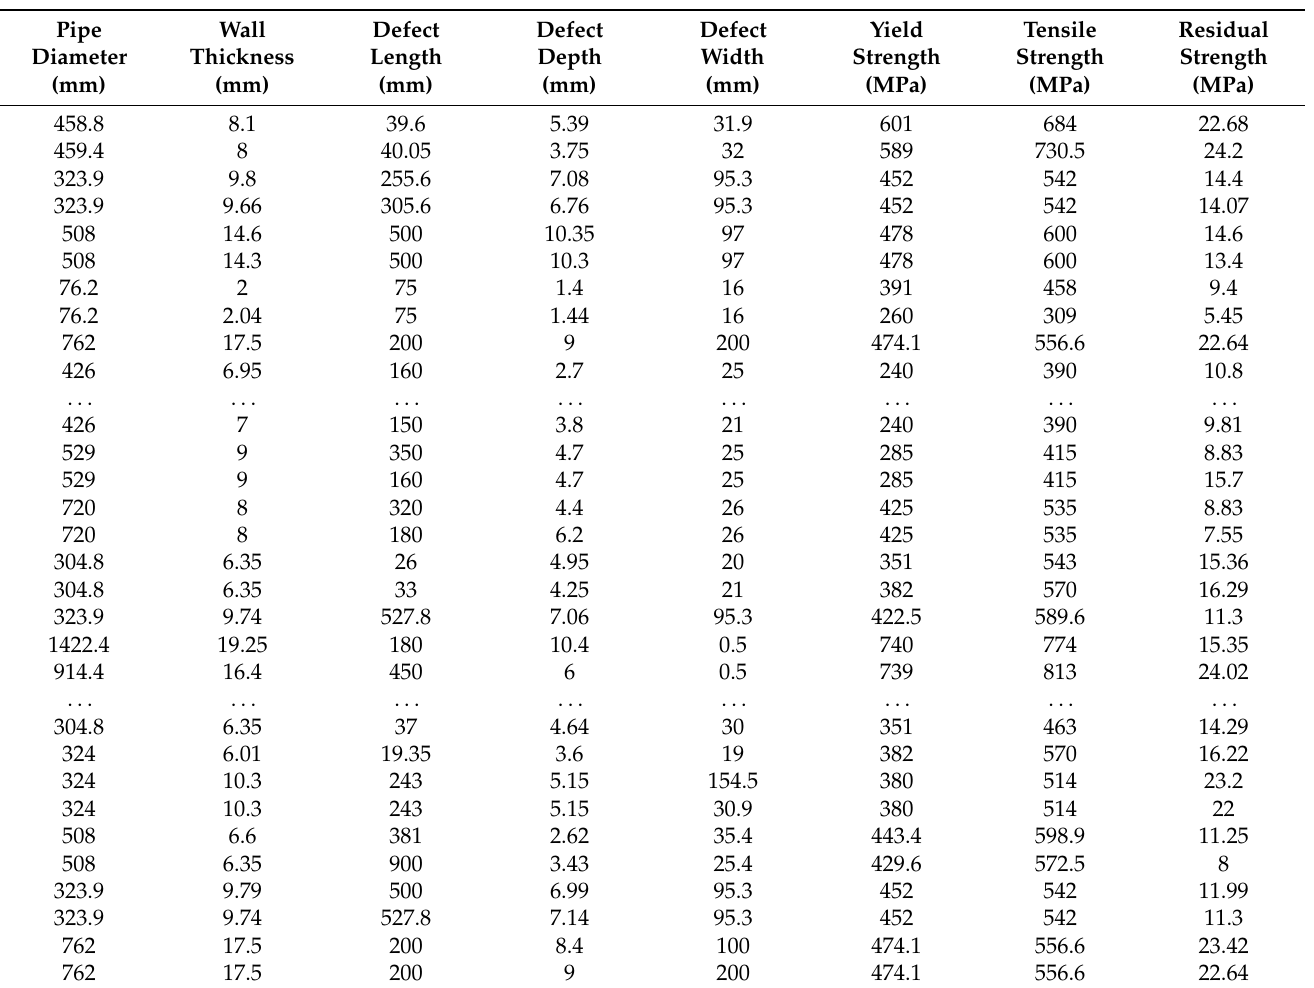
Table 4. Blasting test data of pipelines with defects.